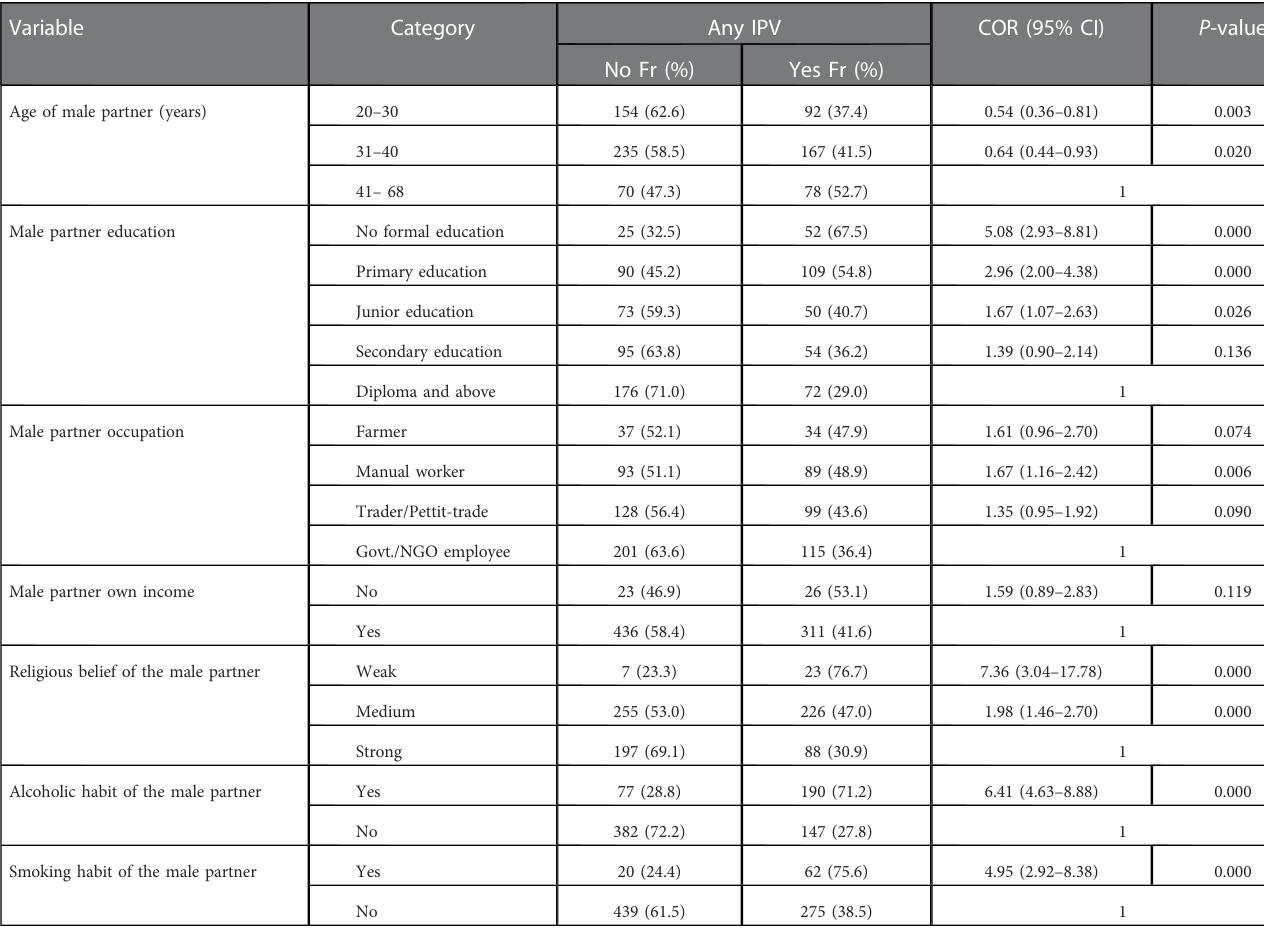
TABLE 6 Bivariate logistic regression analysis of the association of male partner-related factors with IPV among women of reproductive age in Debre Berhan, 2021 ( n =796).